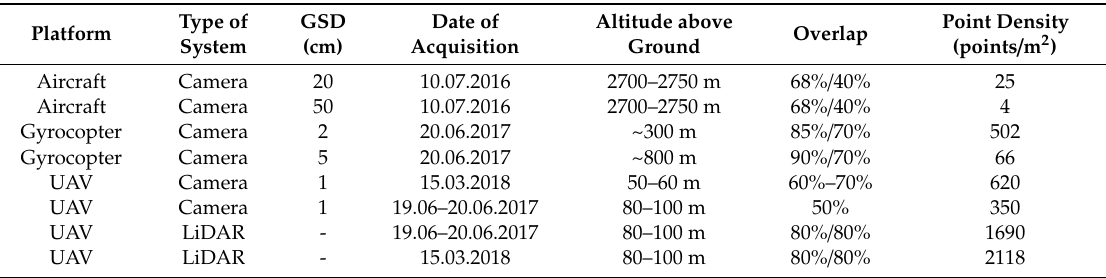
Table 1. An overview of the data collected via UAVs, gyrocopter and aircraft.